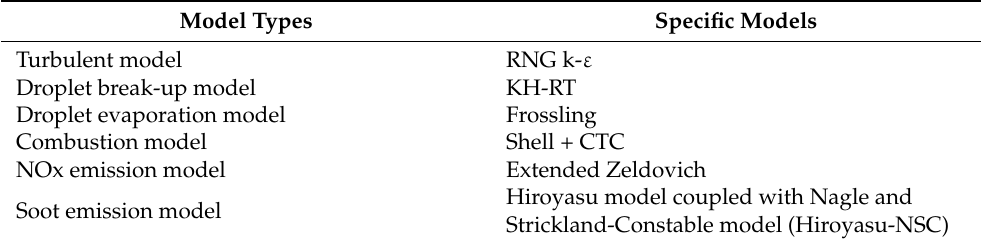
Table 4. The primary physical and chemical models selected for the